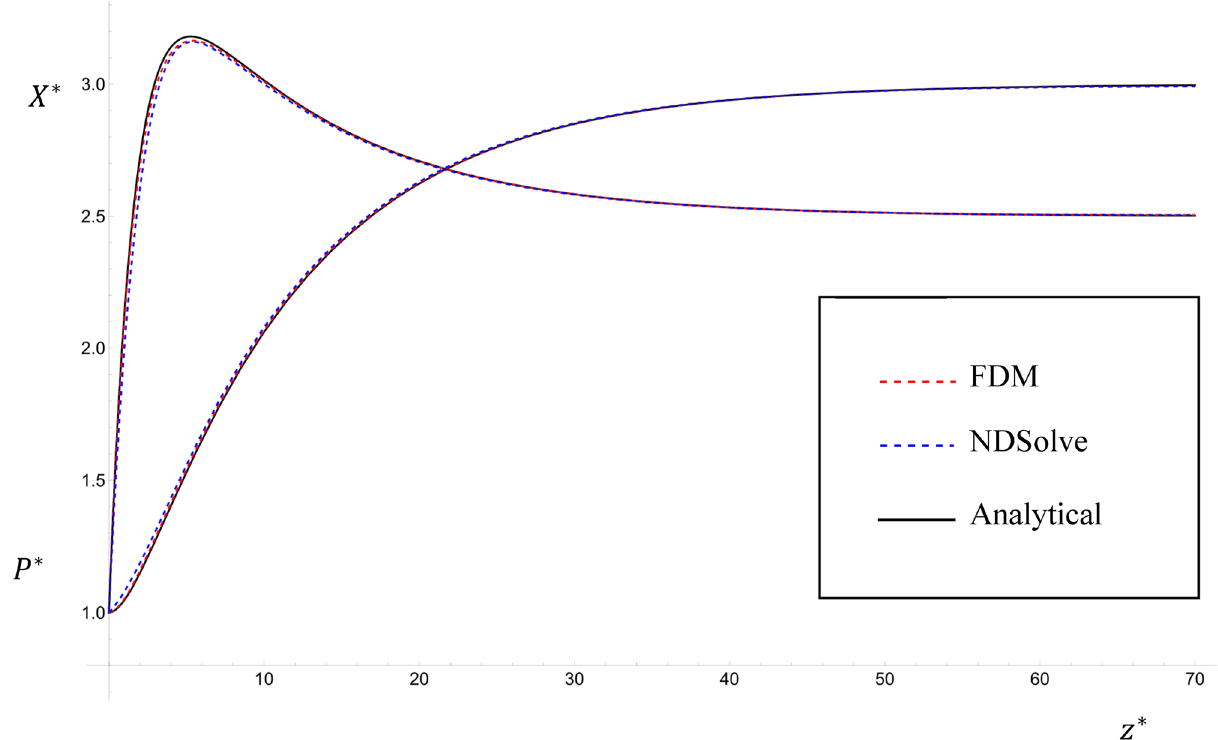
Figure 8. A comparison between the steady-state solutions using the finite difference method (FDM), NDSolve via Mathematica, and the analytical solution given by Eqs. (28,